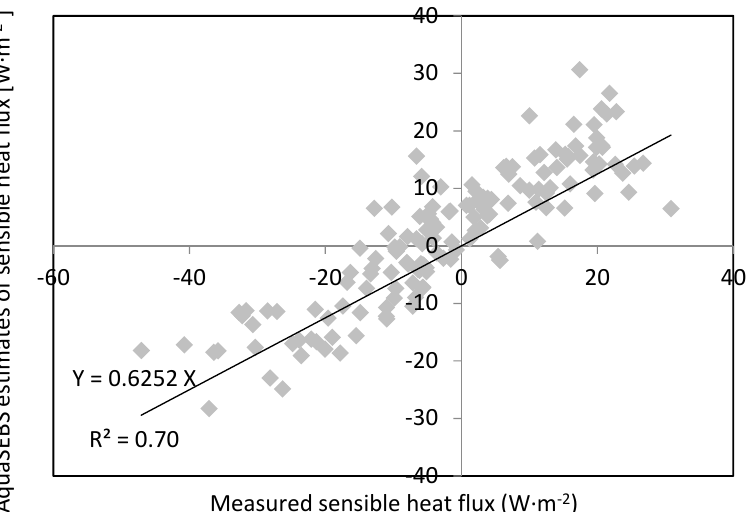
Figure 1. Comparison between the in situ measurements and AquaSEBS sensible heat over the Lake Ijsselmeer.